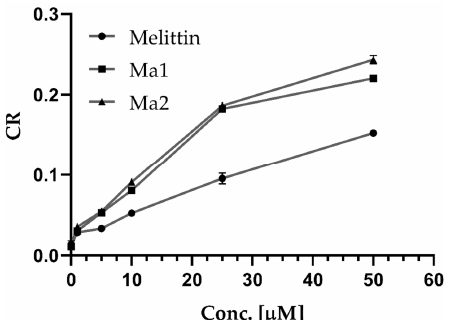
Figure 5. Lipid vesicle assay. PC/PDA vesicles were treated with different amounts of Ma1, Ma2, and melittin as a positive control. Data are reported as the mean ± SD. 2.7. Cytotoxicity of Peptides To establish potential cytotoxic effects, Ma1 and Ma2 were tested on the murine 3T3 fibroblast cell line. The two peptides showed a slight increasing cytotoxicity, conforming to the increasing concentrations of the two peptides, as evidenced by a colorimetric cell viability assay (Figure 6).